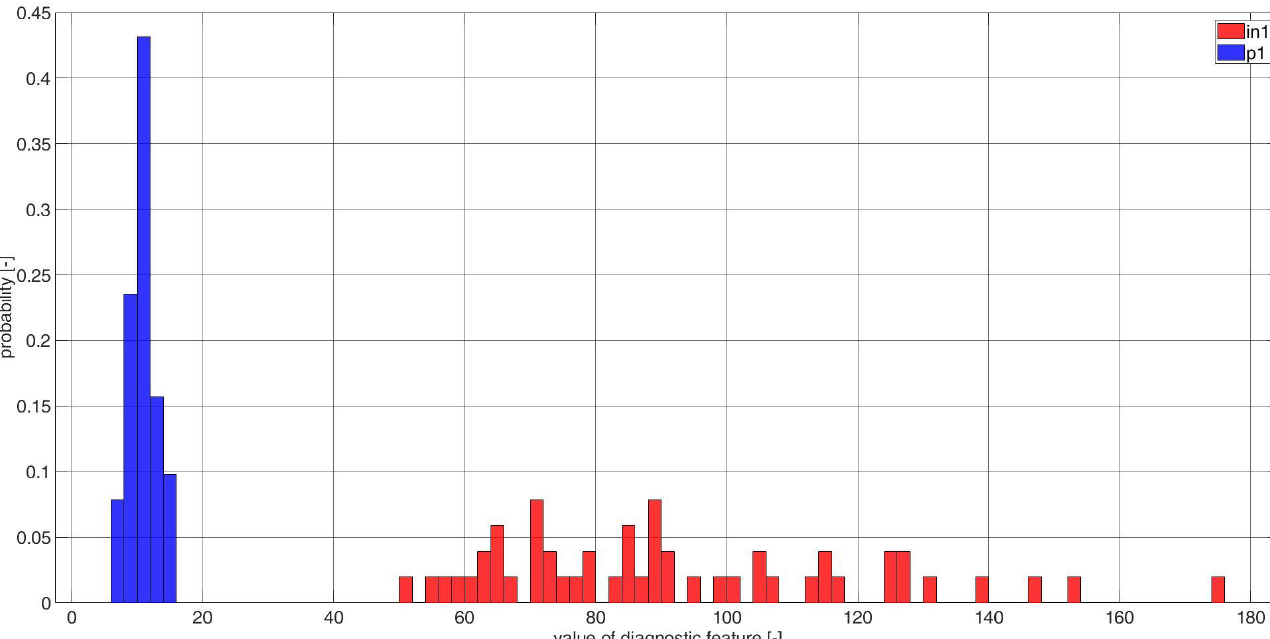
Figure A8. Histograms of diagnostic features based on the CCSM3 (correlation number is 7 — Table A1) bearings in2 and p2.